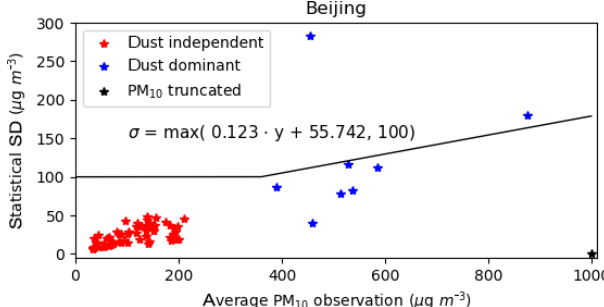
Figure 6. Average vs. standard deviation of the hourly PM 10 obser- vations ranges from 14 April at 08:00 to 17 April at 07:00 in the grid cell of Beijing. See Fig. 5c for the time